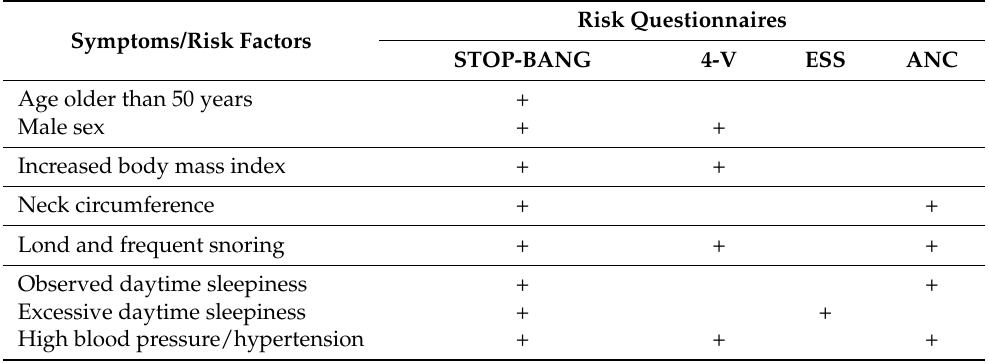
Table 1. Parameters taken into account in the risk assessment of obstructive sleep apnea on individual scales. ANC: the adjusted neck circumference; ESS: the Epworth sleepiness scale; STOP-BANG: the STOP-BANG questionnaire; 4-V: the 4-variable screening tool. Risk Questionnaires Symptoms/Risk Factors STOP-BANG 4-V ESS